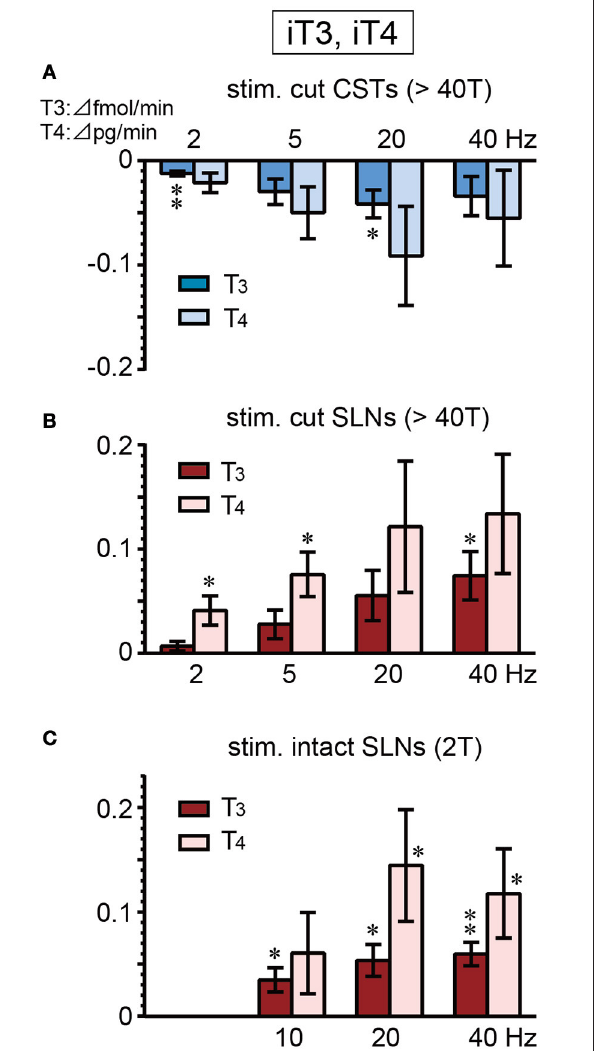
FIGURE 5 | Changes in iT3 and iT4 secretion rate during electrical stimulation of cut CST (A) , cut SLN (B) , and intact SLN (C) at various stimulus frequencies. X-axis: frequency of stimulation. Y-axis: changes in iT3 and iT4 secretion rate from prestimulus control values. Columns and vertical bars show the mean ± standard error. Significant differences were determined by comparison with the prestimulus control values (* p < 0.05, ** p < 0.01).